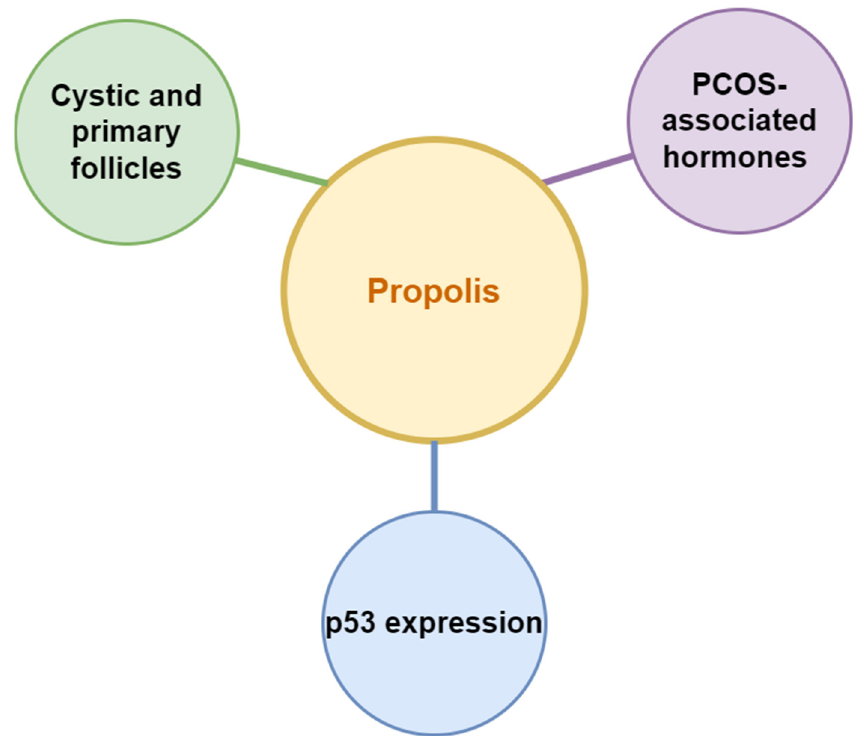
Figure 7. Propolis affected parameters related to PCOS .